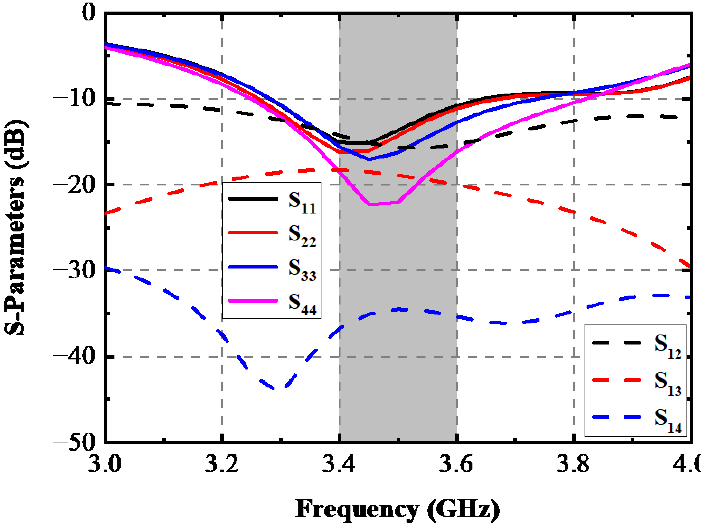
Figure 7. Simulated S-Parameters when this AP system is in SHM mode.